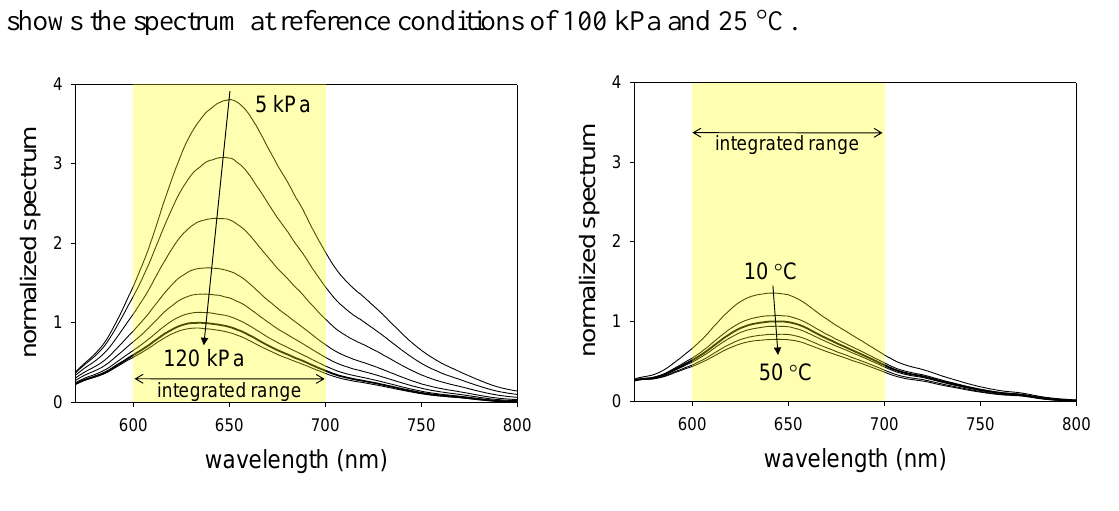
. Thick line 00.100